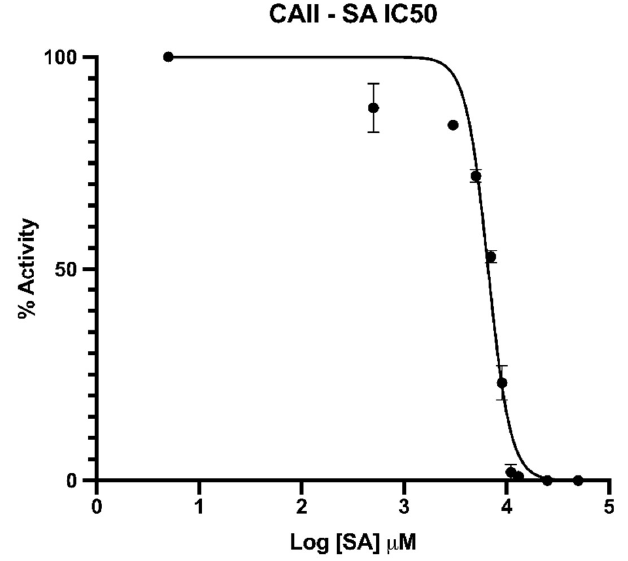
Figure 2. Inhibition curve of CAII with SA. Calculated IC50 of 6.6 mM. The error bars represent the standard deviation of 3 kinetic experiments performed.